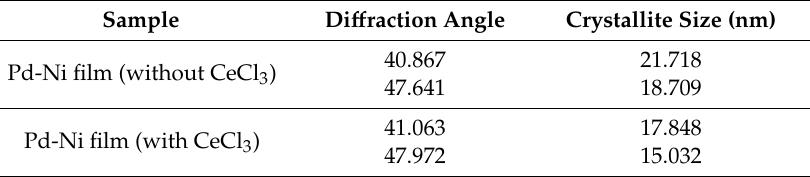
Figure 2. The XRD patterns of the Pd-Ni alloy films. Table 3. The crystallite sizes of the Pd-Ni alloy films.